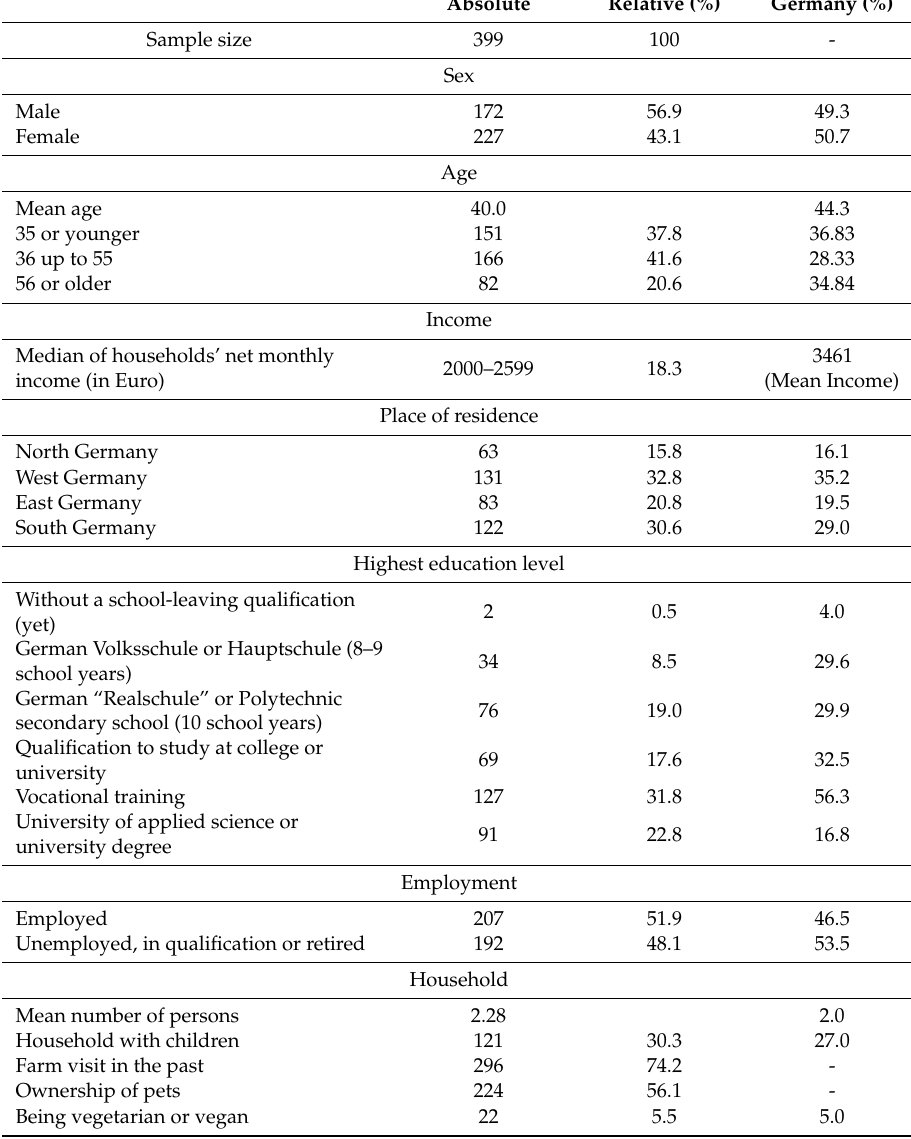
Table 1. Sample characteristics.